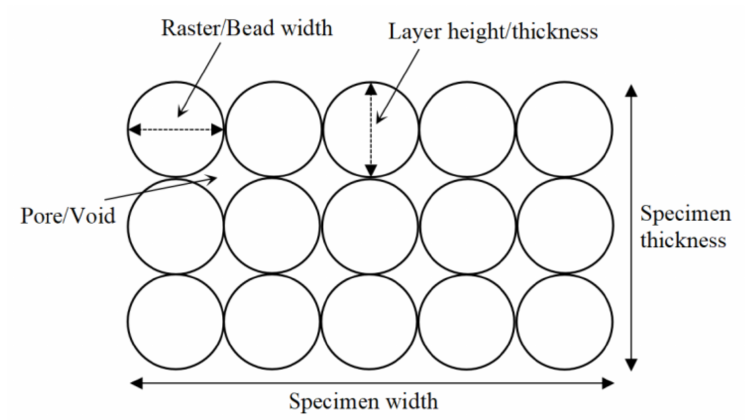
Figure 3. Schematic illustration of the layer height and raster width.